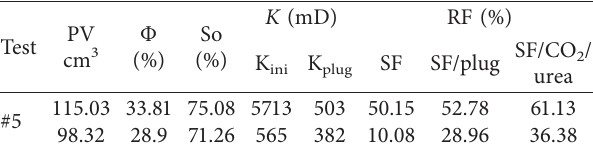
Table 4: Physical properties and development effects of sand pack models with different permeabilities.